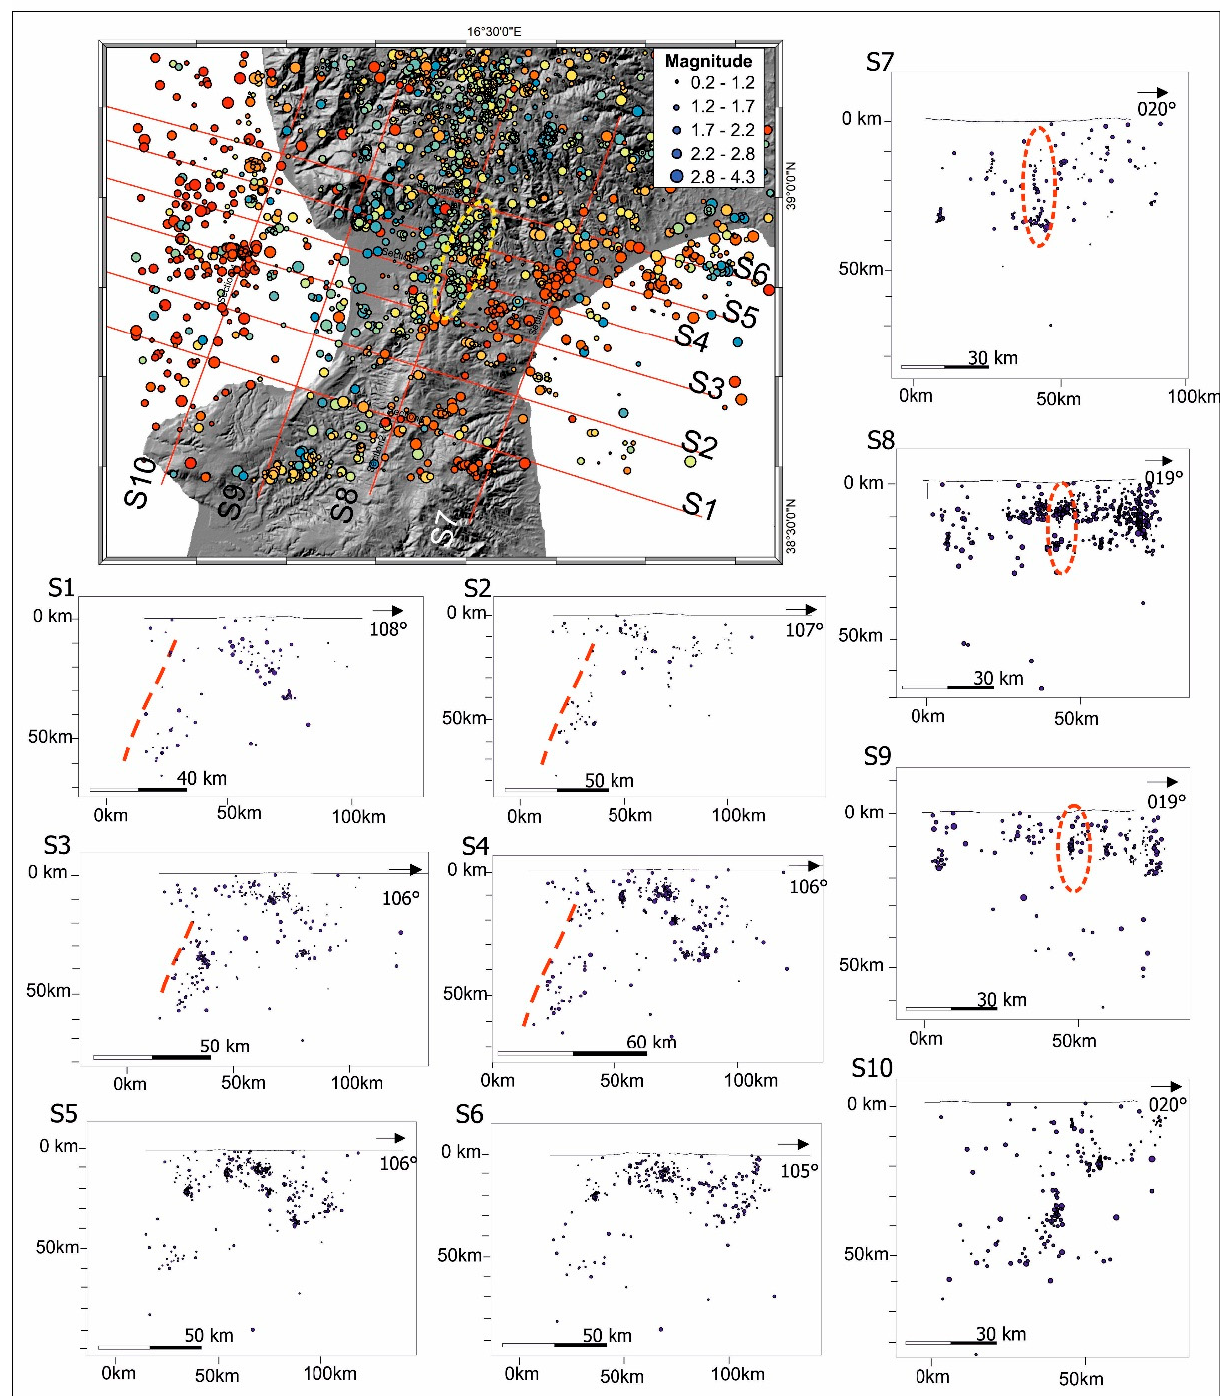
Figure 5. Map of instrumental seismicity of central Calabria and relative sections. Yellow ellipse in the map shows a roughly N–S alignment probably related to the occurrence of a blind normal fault (see text); red dashed lines in sections from s1 to s4 point out intermediate and deep earthquakes depicting the subducting Ionian slab; red ellipses in the sections from s7 to s9 make evident the high concentration of events in correspondence with the LCFS.